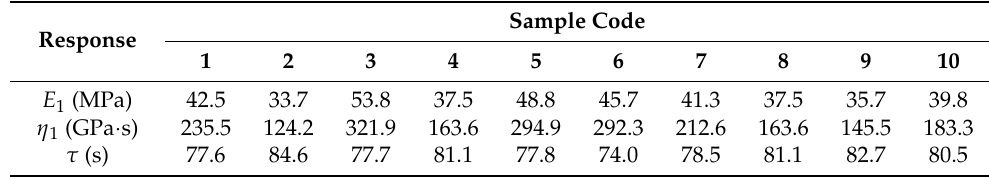
Table 9. Viscoelastic responses of SLD for asphalt mixtures